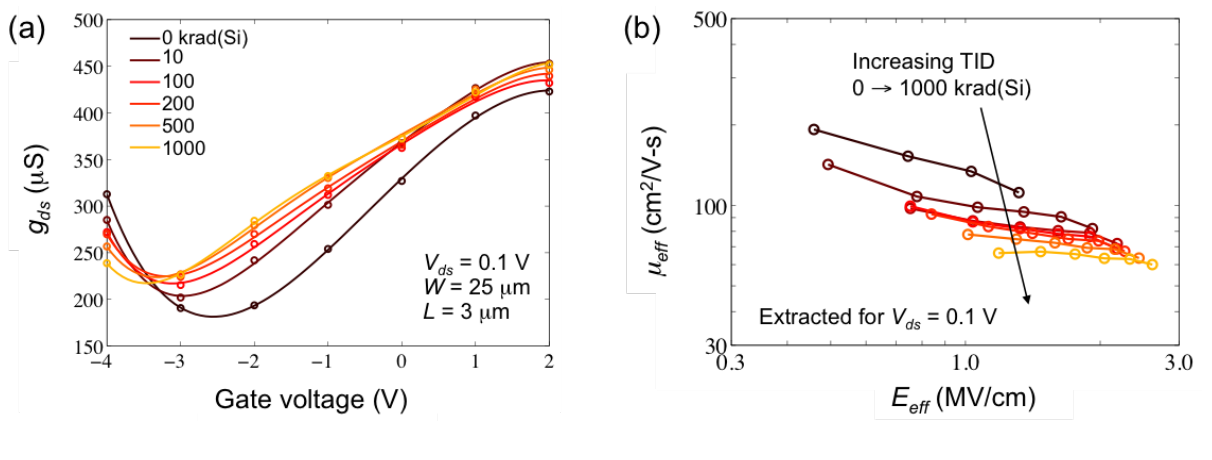
Figure 7. ( a ) Drain conductance ( g for increasing dose levels up to 1000 krad(Si); ( b ) Effective electron mobility ( μ as a function of the effective vertical field ( E 1000